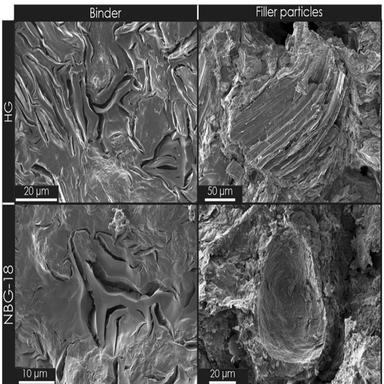
Fractography SEM micrographs of the binder and filler of a historical HG grade and medium-coarse NBG-18 grade.